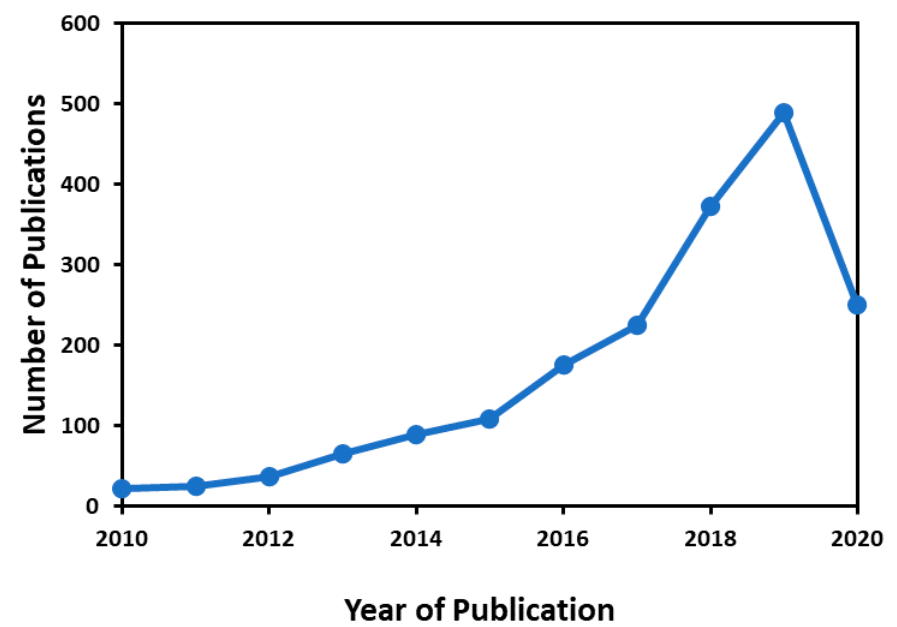
Figure 2. Survey on the number of published research papers since 2010. Database acquired from the advanced Scopus scholar search system with the terms “membrane distillation” and “nanomaterials” as in April 2020.